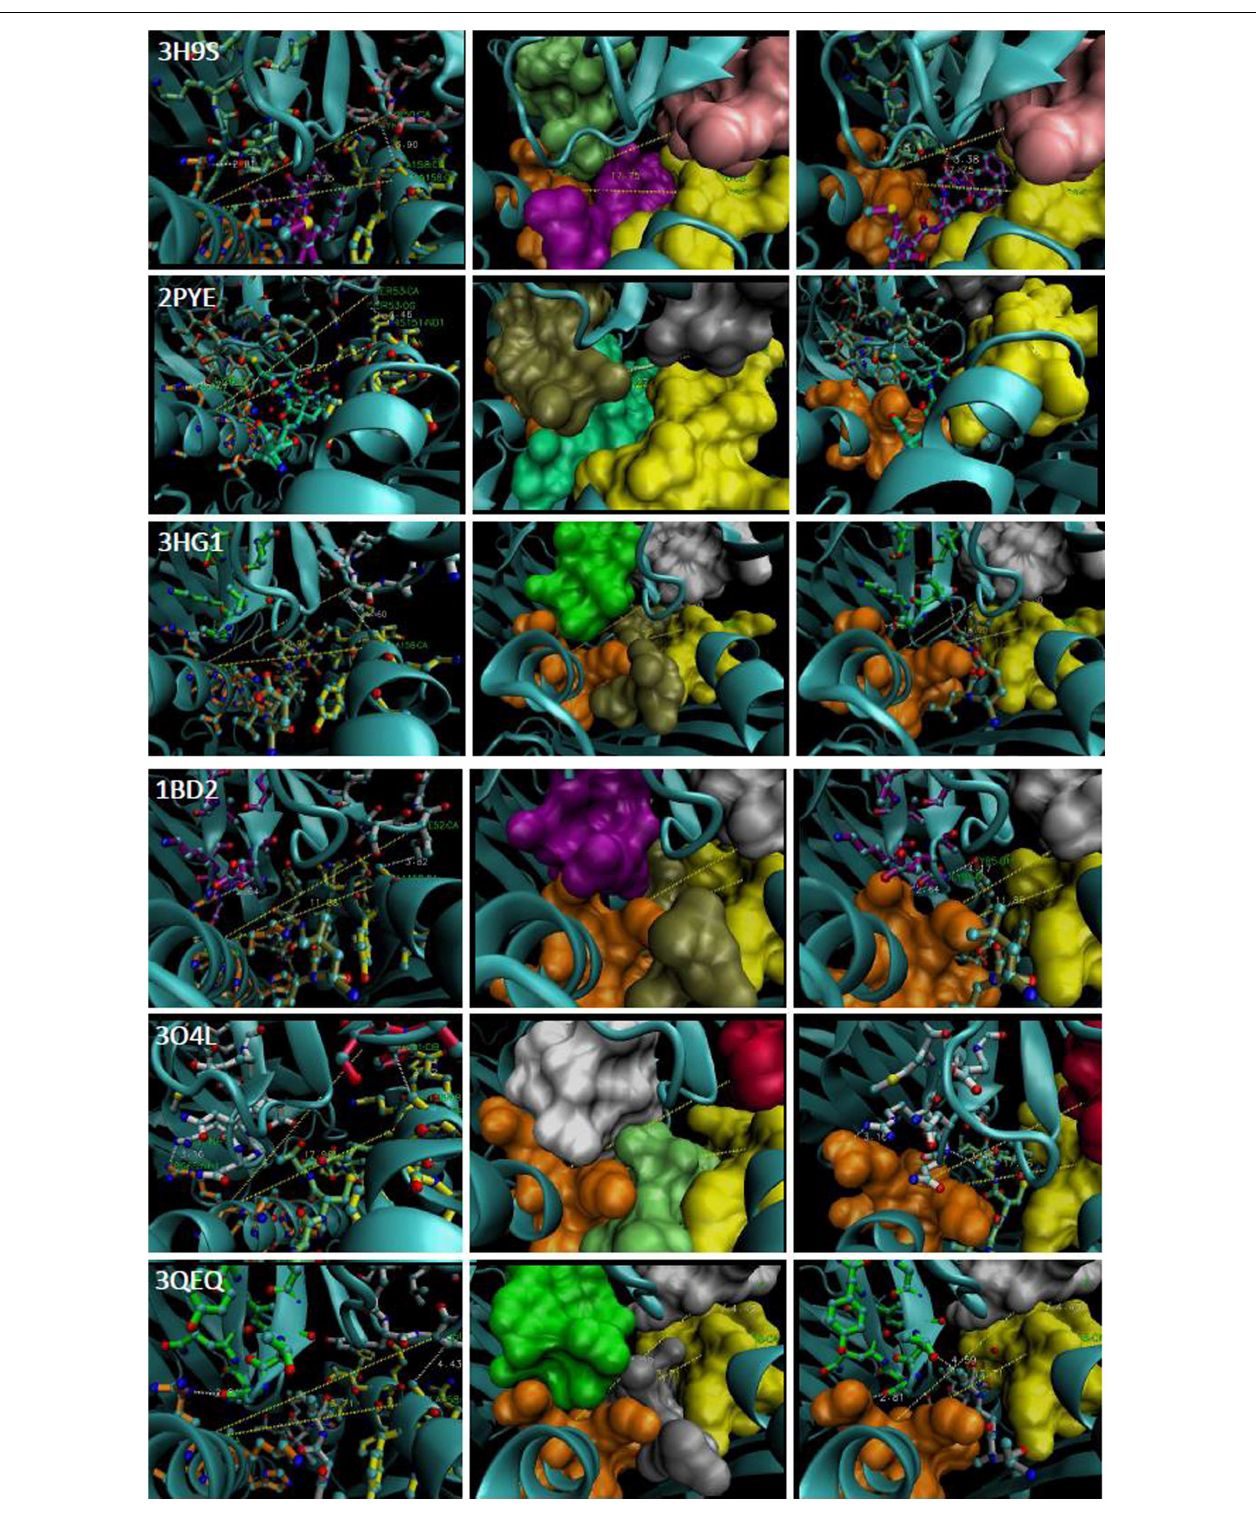
(2PYE), white (3HG1), white (1BD2), rose (3O4L), and white (3QEQ); cyan ribbon alpha carbon backbones. Peptides: magenta (3H9S), foam (2PYE), tan (3HG1), tan (1BD2), lime (3O4L), and silver (3QEQ). The R65-angle was measured with VMD (shown as yellow trace). CDR3 α :peptide contacts are shown as white